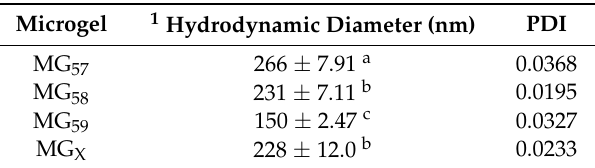
Table 1. Average hydrodynamic diameter and polydispersity index (PDI) of Blg microgel suspensions prepared at different pH values with and without crosslinking with glutaraldehyde.